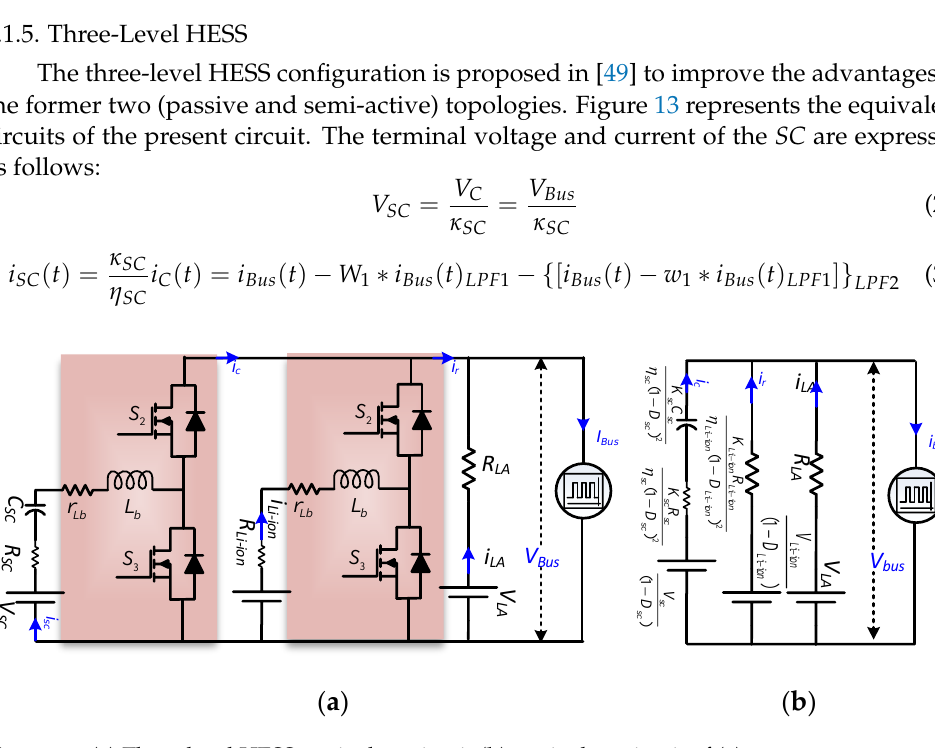
Figure 13. ( a ) Three-level HESS equivalent circuit ( b ) equivalent circuit of ( a ).